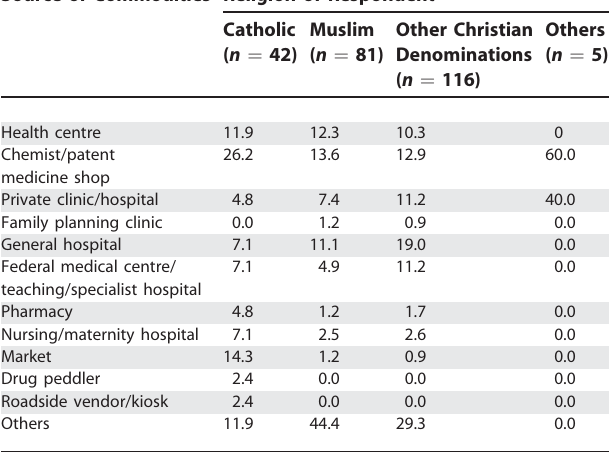
Table 5. Marital Status and Source of Commodities by Percentage Source of Commodities